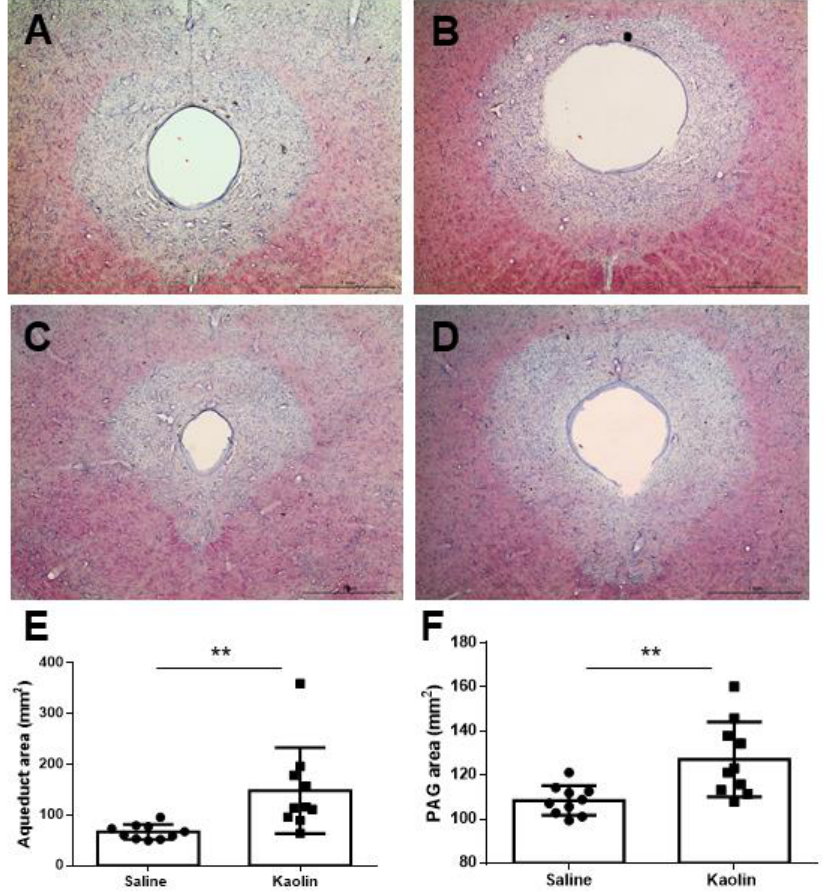
Figure 1. Effects of kaolin-induced hydrocephalus at the aqueduct and PAG. Representative photomicrographs of thionin-stained sections collected at about 0.70 ( A , B ) and 2.20 mm ( C , D ) rostral to the interaural line after saline ( A , C ) or kaolin ( B , D ) injections into the cisterna magna. Animals injected with kaolin presented increases in the areas occupied by the aqueduct ( E ) and PAG ( F ) areas. Saline n = 10; Kaolin n = 10. Scale bar in ( A – D ): 1mm. Data in ( E , F ) are presented as means ± SEM. ** p < 0.01.